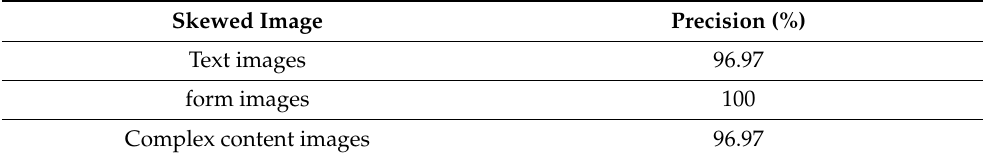
Table 1. Precision of image classification algorithm.